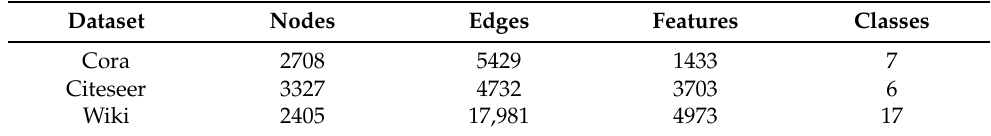
Table 1. Summary of